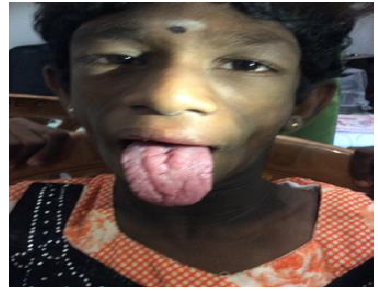
Figure 1: Macroglossia in a child with BWS